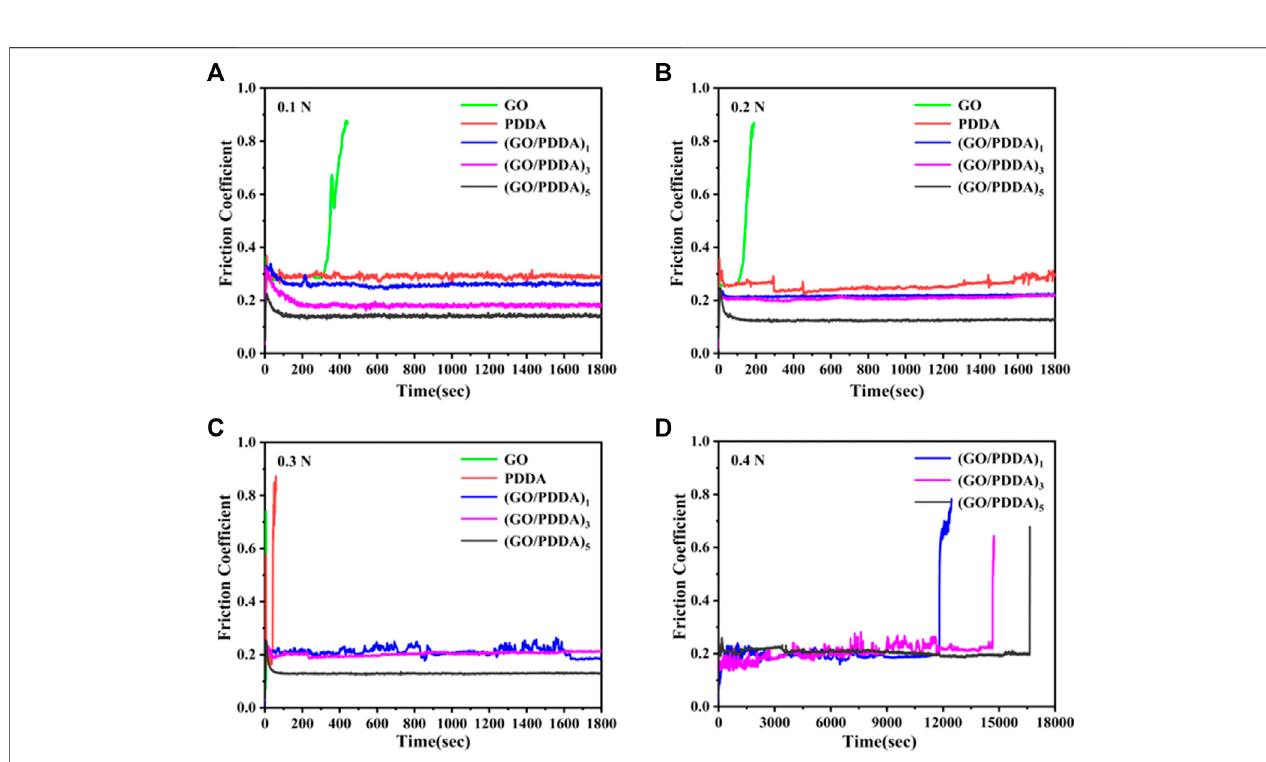
Frontiers in Chemistry |